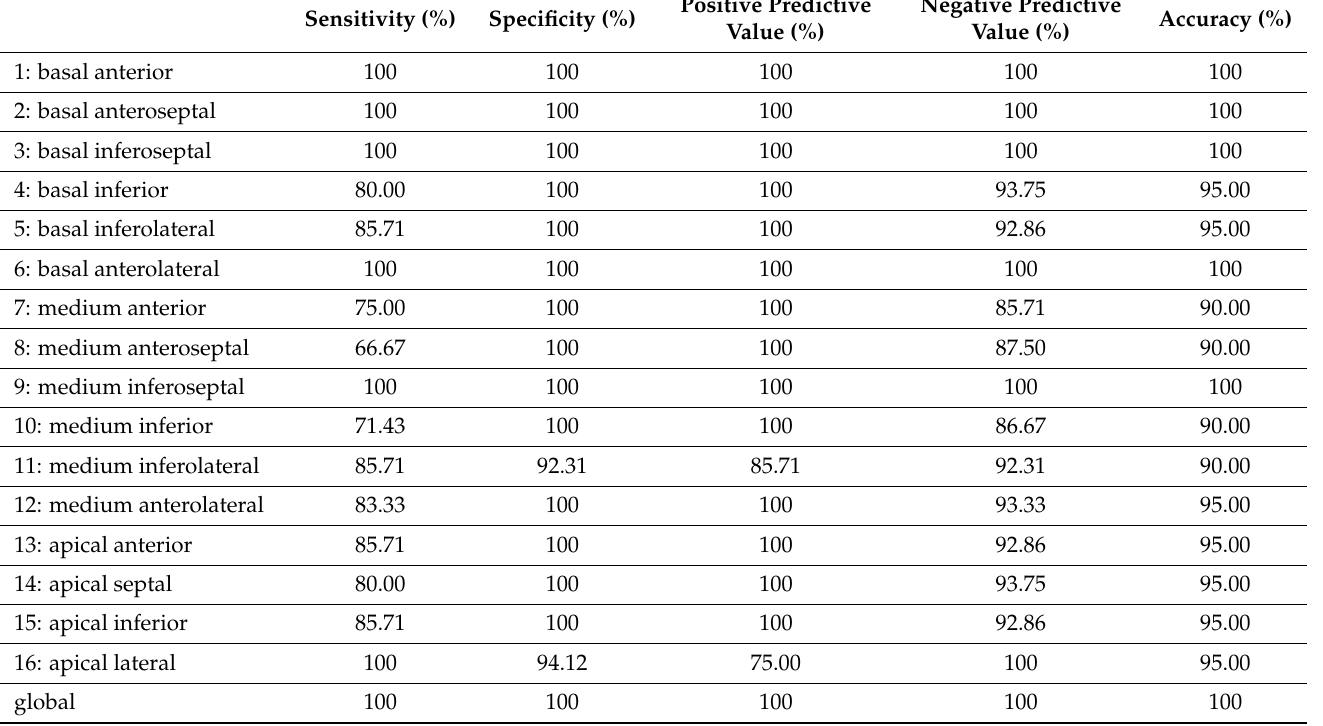
regional distribution of the T2* values exhibited small differences (<3 ms) associated with